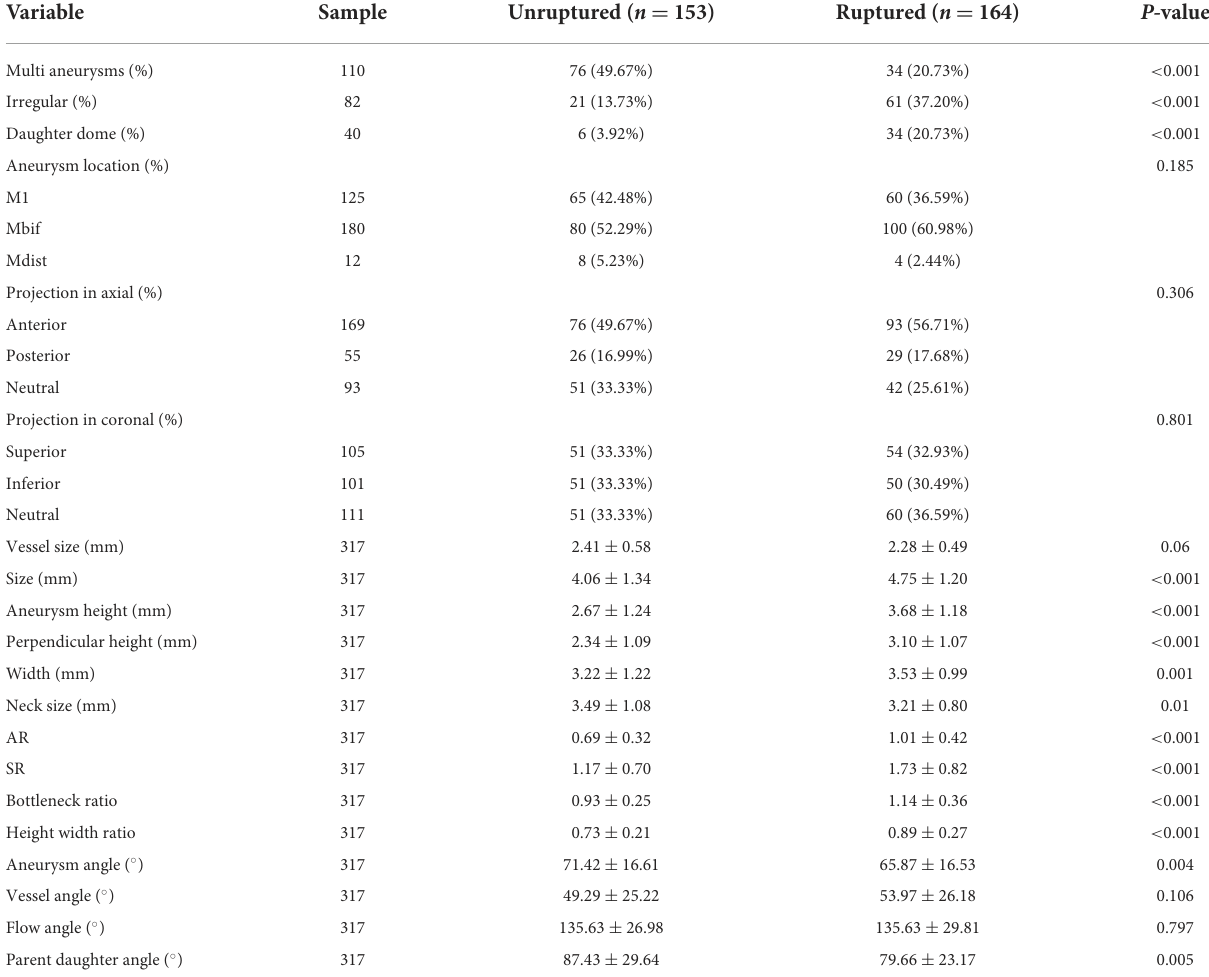
TABLE 1 The univariate analysis of morphological features of small middle cerebral artery (MCA) aneurysms in the training cohort. Variable Sample Unruptured ( n = 153) Ruptured ( n = 164)